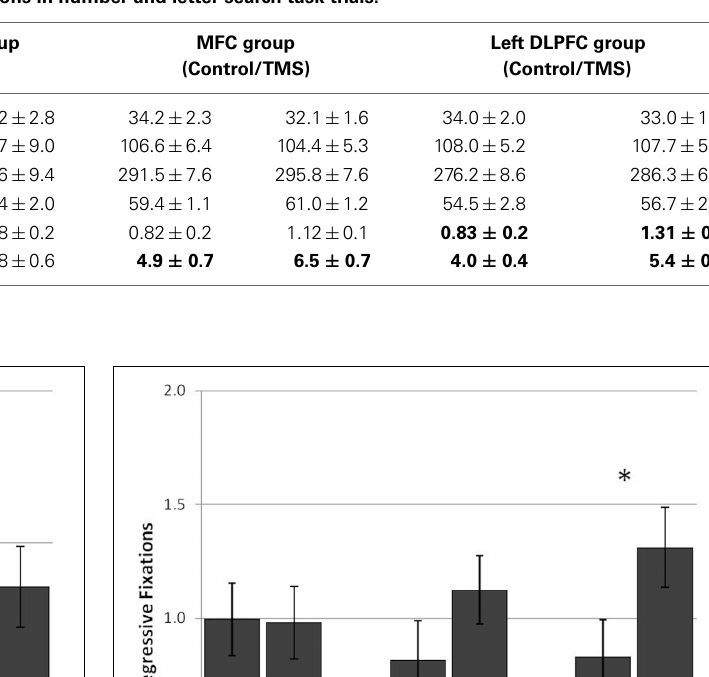
Table 2 | Descriptive statistics (mean, SE ) in the right dorsolateral prefrontal cortex group ( n = 18), MFC group ( n = 18) and left dorsolateral prefrontal cortex group ( n = 18) for control and TMS conditions in number and letter search task trials.